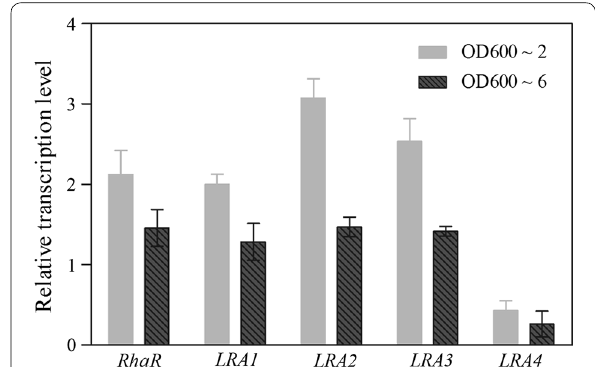
Fig. 3 Relative transcription levels of rhamnose utilization genes in P. pastoris GS115m/ LacB grown in YPR medium. Four genes rhamnose utilization of LRA1 , LRA2 , RhaR , LRA3 , and LRA4 was detected in P. pastoris GS115m/ LacB grown in YPR medium to OD 600 ~ 2 and OD 600 ~ 6, respectively. The corresponding gene in P. pastoris GS115/ LacB was used as the control, and the relative expression value of each gene was designated as 1